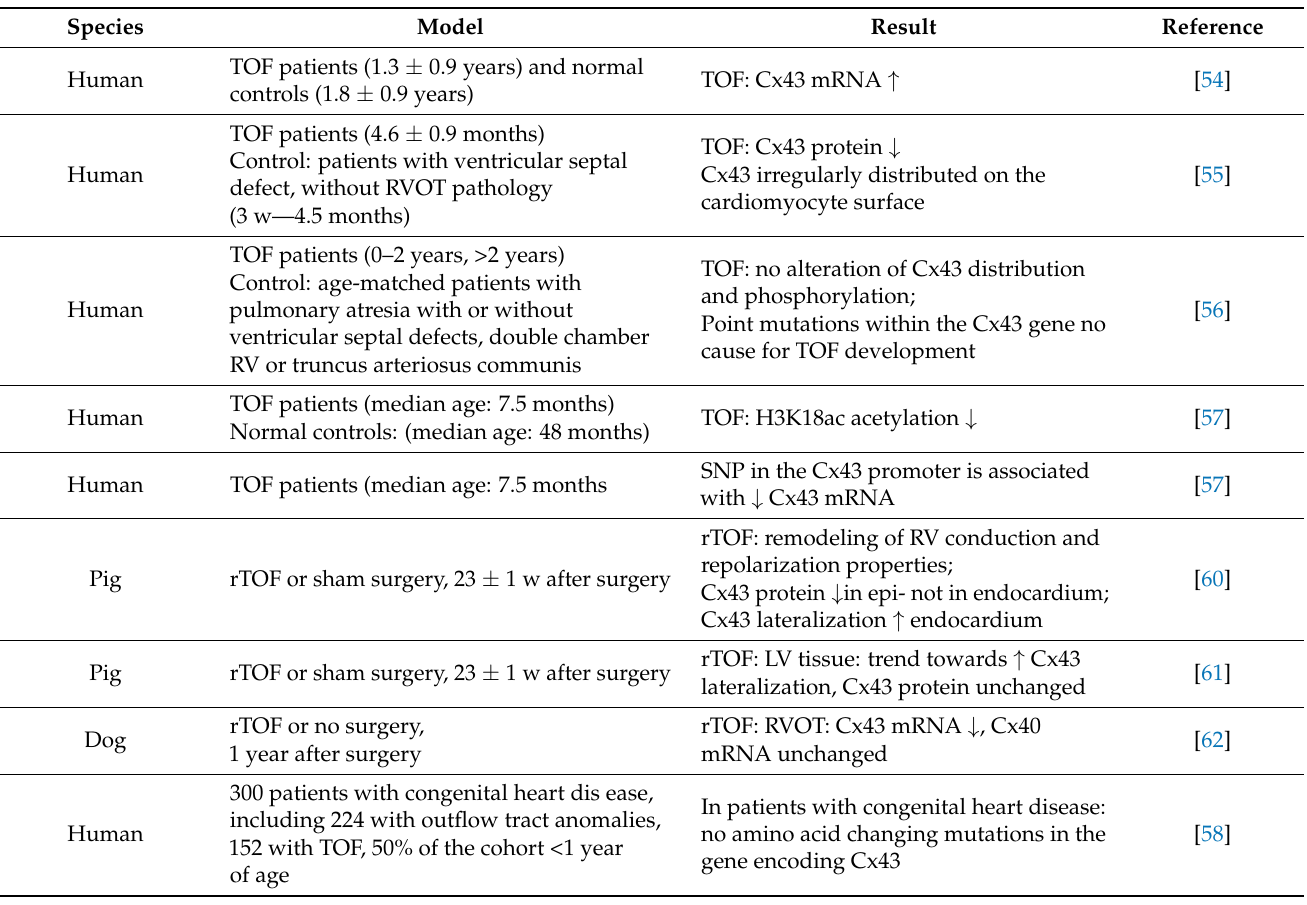
Table 2. Connexins in tetralogy of